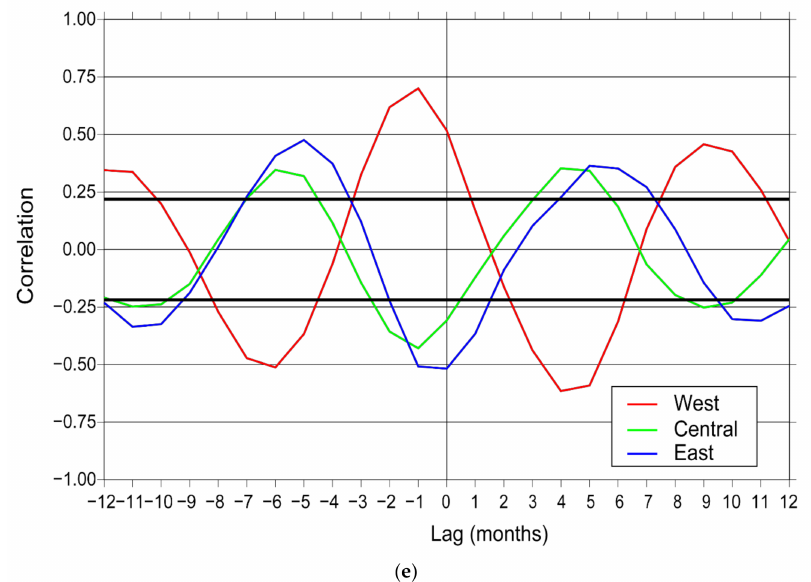
Figure 3. Seasonal signal Mode 1 of Himalaya and its interpretation. ( a ) Empirical orthogonal functions (EOF) Mode 1 of Himalaya. ( b ) Grid-wise correlation of mode vs. rainfall. ( c ) Grid-wise correlation of mode vs. snowfall. ( d , e ) Cross correlations of the three regions demarcated and marked in red against rainfall and snowfall,